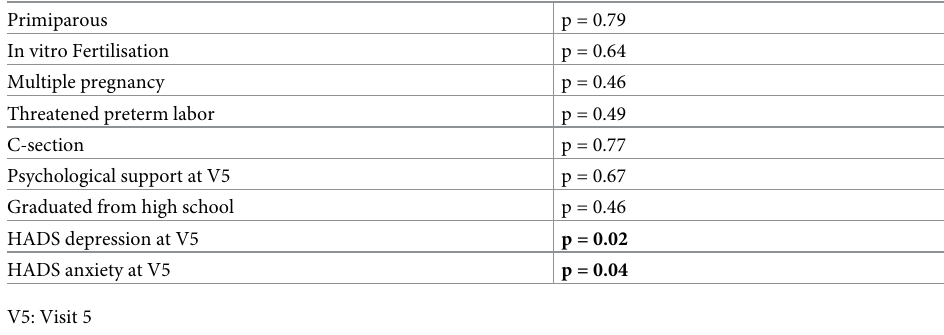
Table 4. Association between mPPQ scores at V5 and characteristics of the dyads. Primiparous p = 0.79